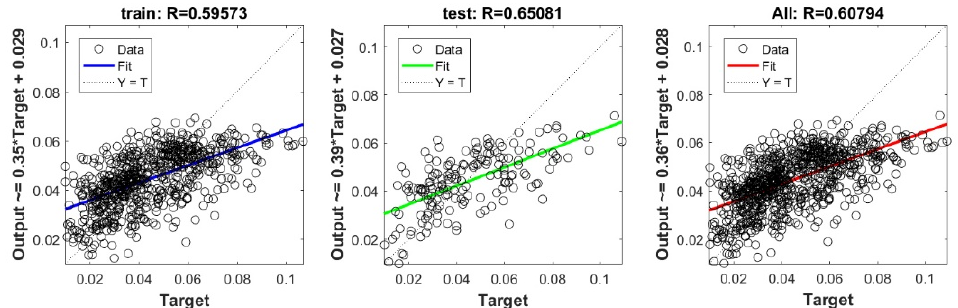
Figure A25. Scatter plots between target and output value by the PSO-Lasso model.